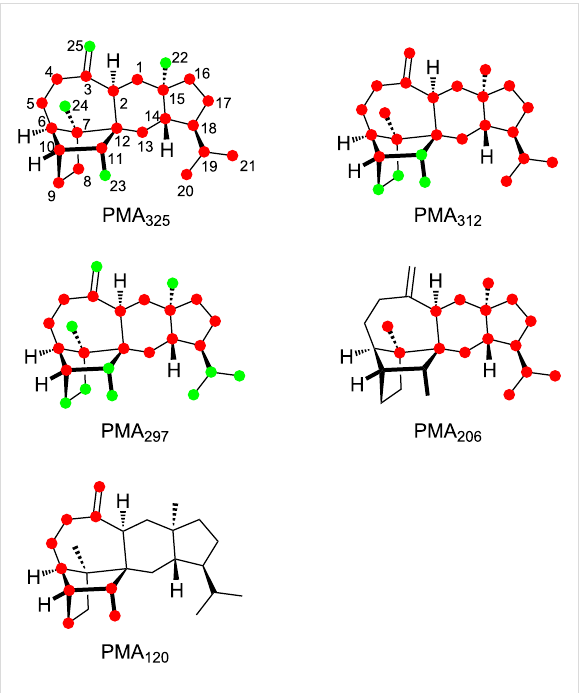
Figure 4: The position-specific mass shift analyses for 3 . Carbons that contribute fully to the formation of a fragment ion are indicated by red dots, partially contributing carbons are marked by green dot, and unla- belled carbons do not contribute and are thus cleaved off by the frag- mentation